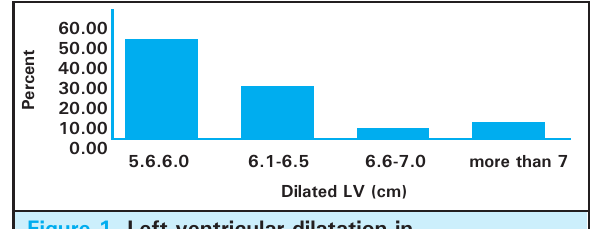
Figure 1. Left ventricular dilatation in echocardiography.